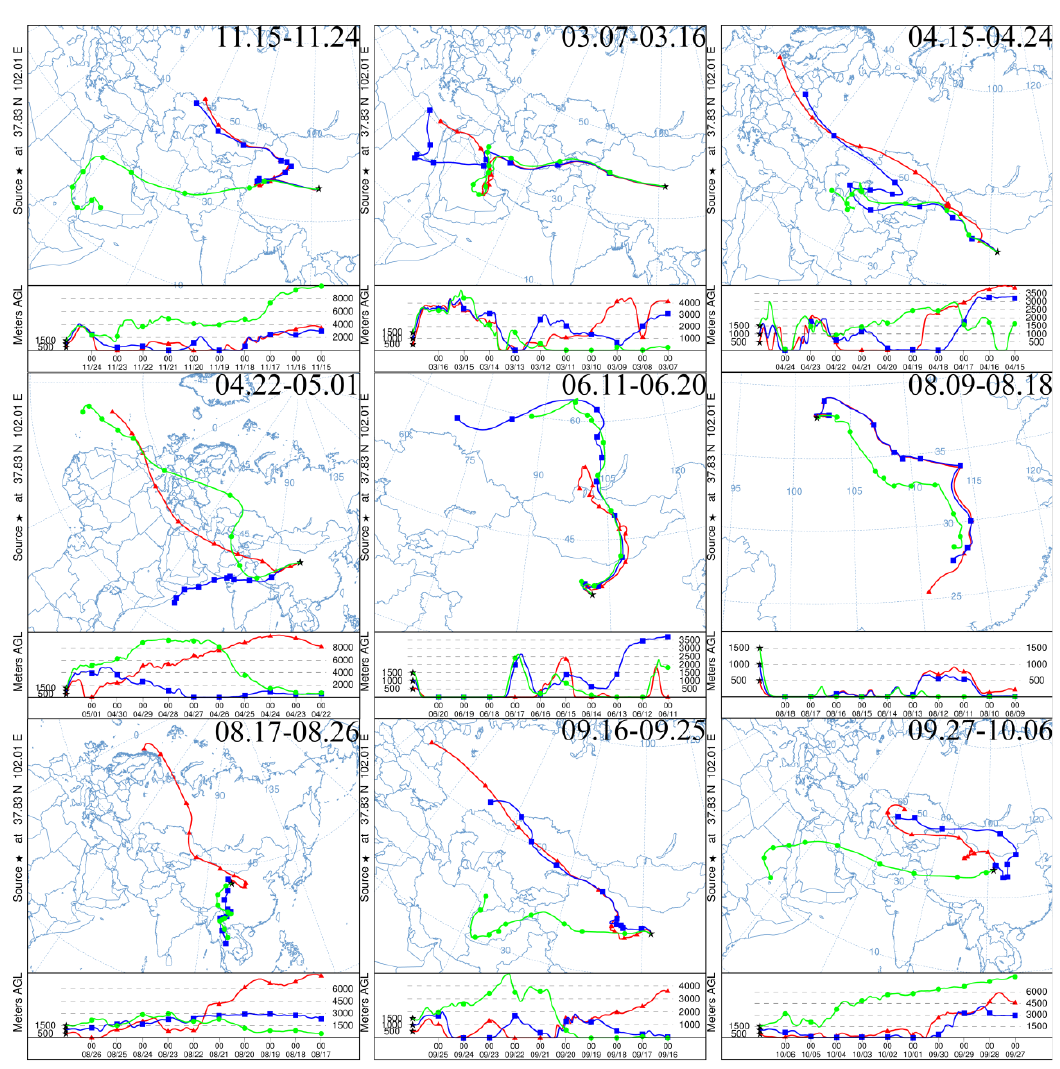
Figure 10. Backward trajectory of the water vapor source in the study area.